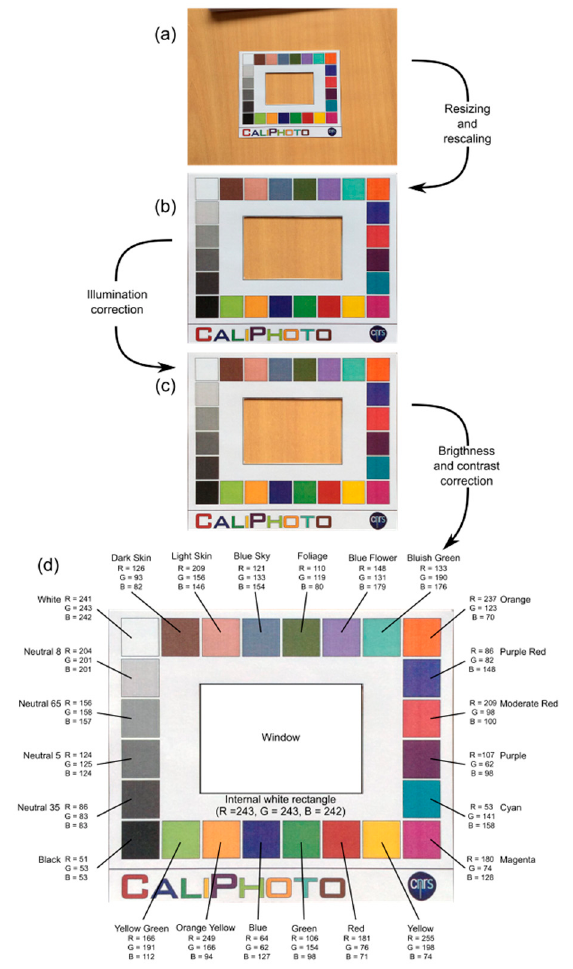
Figure 2. Processing of the reference image of the colour plate. ( a ) Photograph of the colour plate made using an iPad camera. ( b ) Resized and rescaled image. ( c ) Image after removing the plane corresponding to the illumination continuum over the whole area. ( d ) Final reference image of the colour plate after brightness and contrast correction.